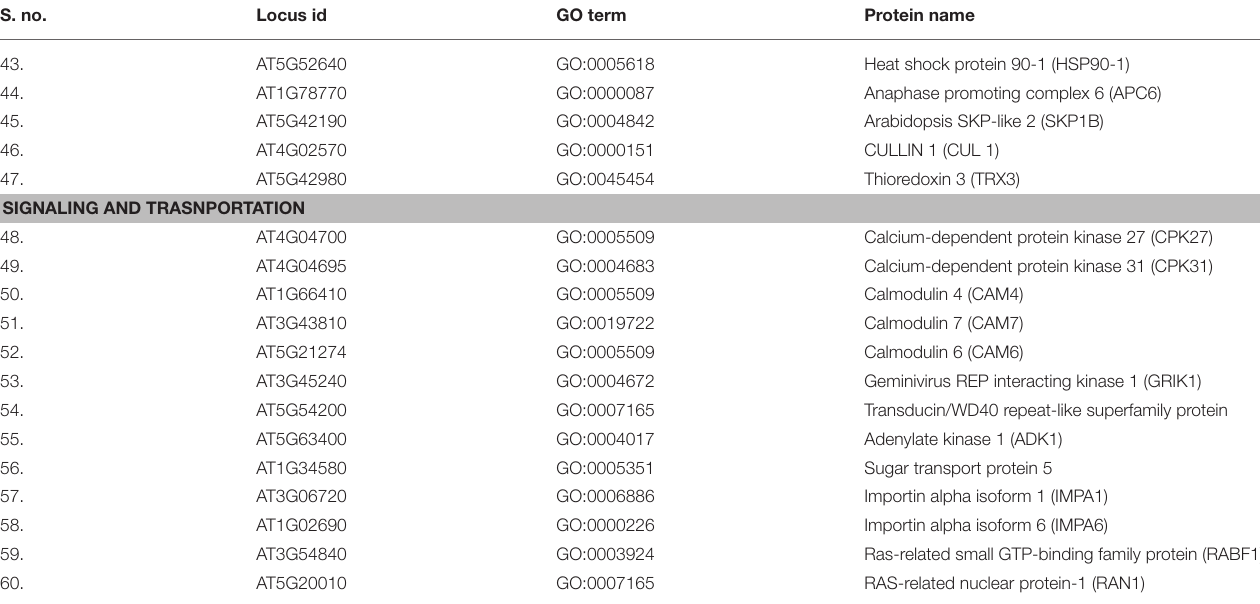
TABLE 2 | Proteomic expression and functional distribution of 08 regulatory hubs in PGN during Podophyllum radicle protrusion step of seed germination. Spot No. (2-DE gel)